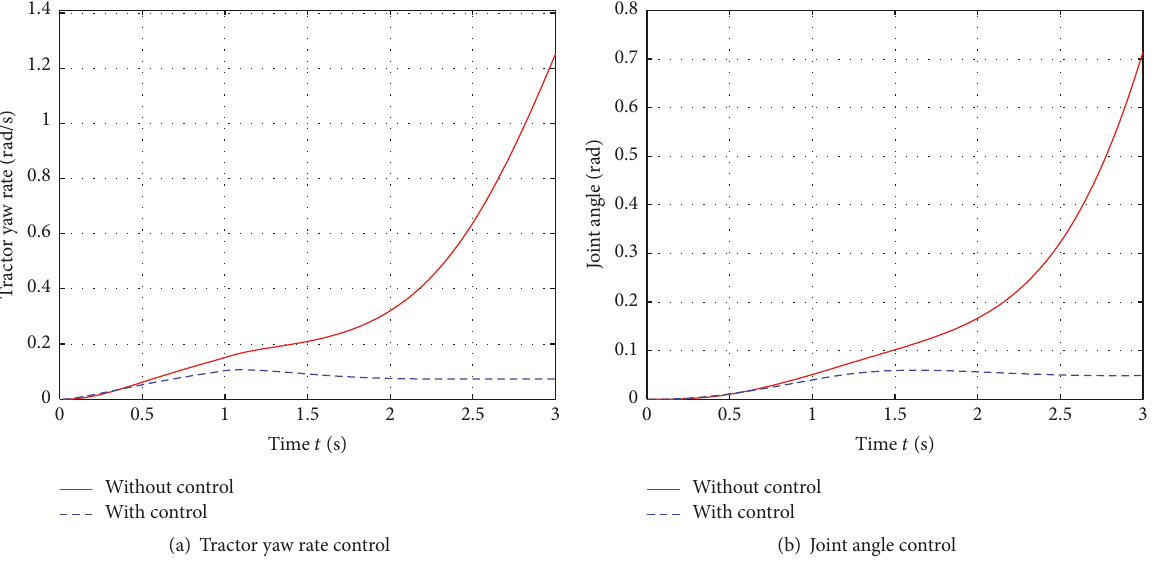
Figure 10: Typical contract of vehicle dynamic variables in critical steady